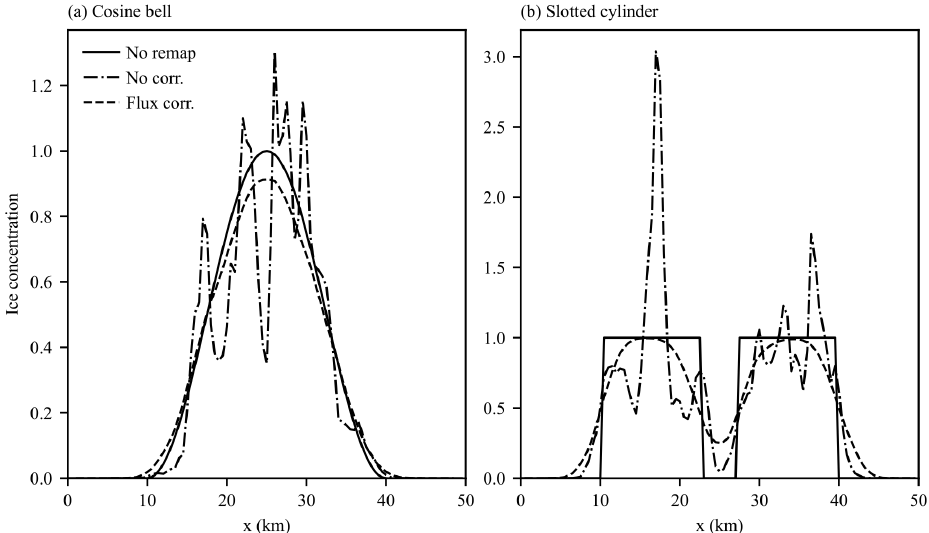
Figure 9. Cross section ( y = 50km) of ice concentration for the stationary two-dimensional test case with randomized orientations for the initial (a) cosine bell and (b) slotted cylinder particle